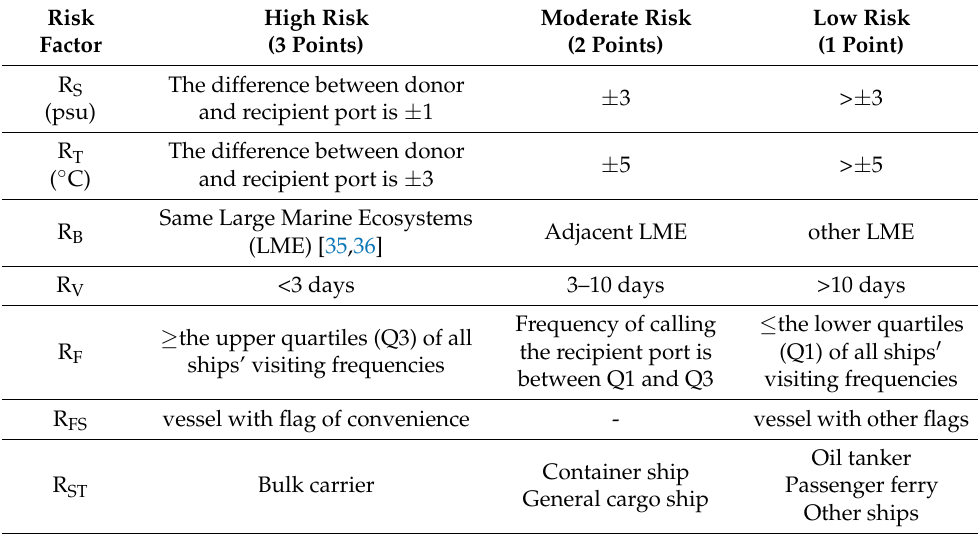
Table 3. Evaluation criteria of risk